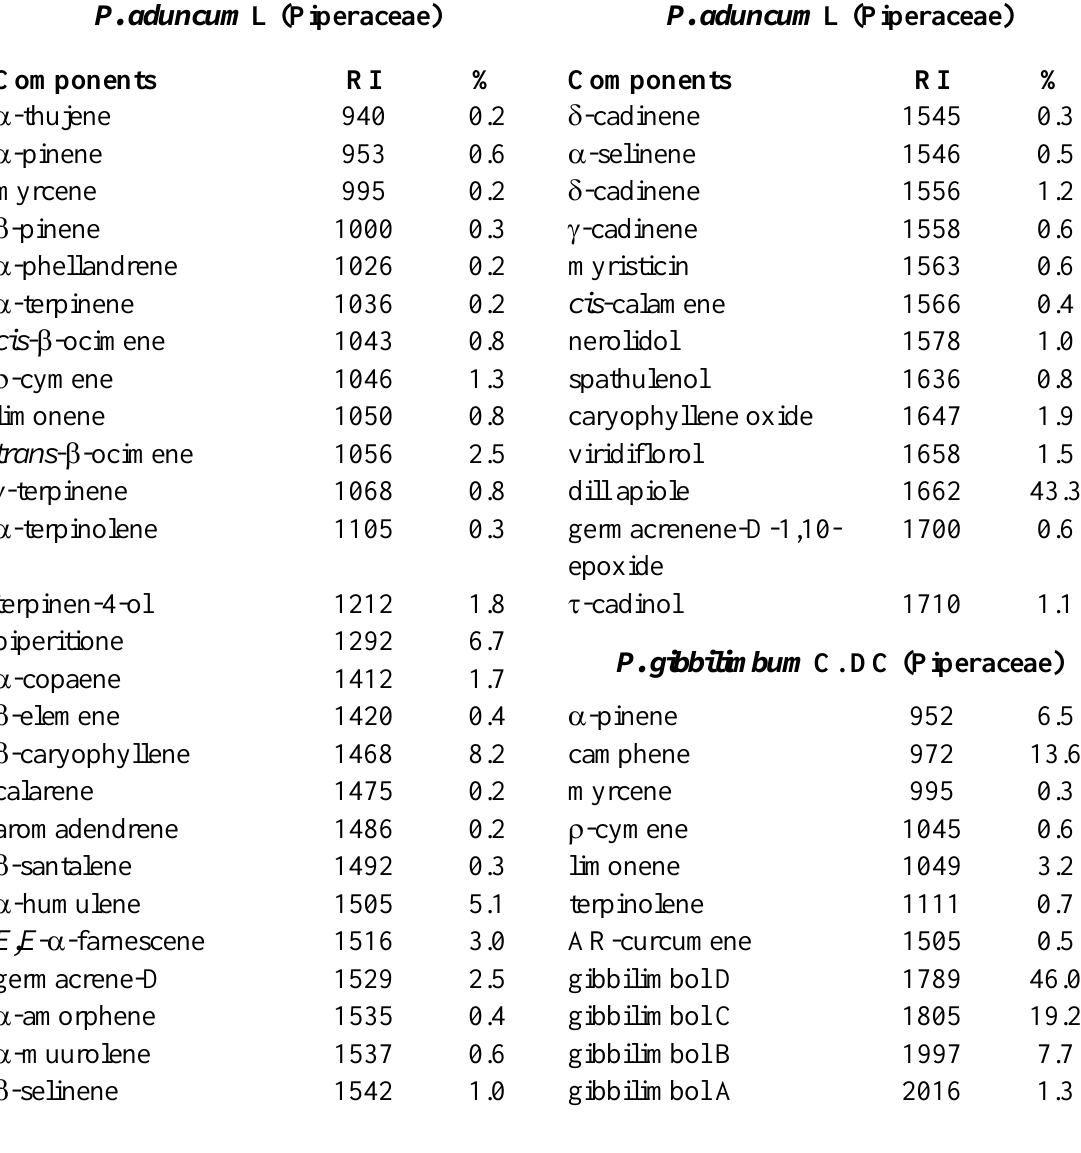
Table 1. The essential oil components (% area) of P. aduncum and P. gibbilimbum (Piperaceae) and their corresponding retention indices